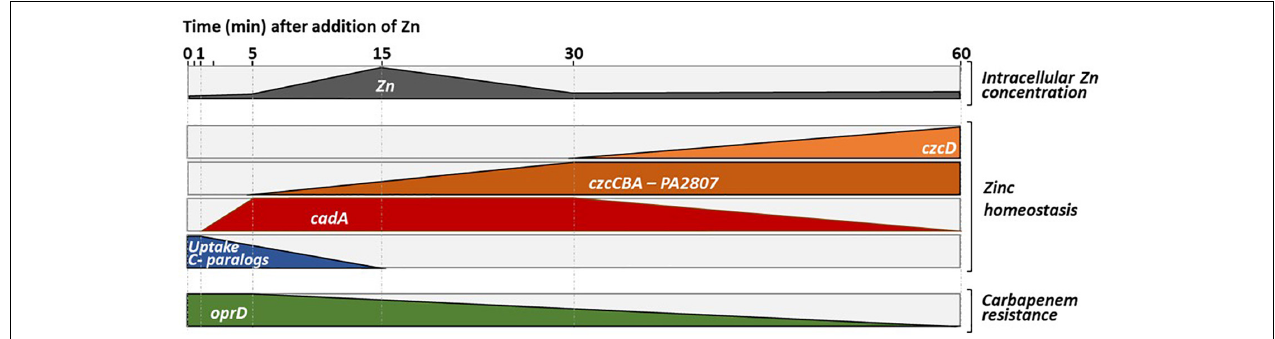
FIGURE 8 | Representation of the dynamics of Zn homeostasis in Pseudomonas aeruginosa. The first block represents the intracellular Zn concentration, which increases when the cells move from a Zn-poor to a Zn-rich environment. An increase in intracellular Zn concentration is observed for up to 15 min, the time it takes for the import systems to be repressed and for the export system to start to eliminate the excess Zn (see second block and discussion). Later it appears that the ATP-consuming CadA system, is replaced by a less energy-demanding CzcD system that takes over to pump cytoplasmic Zn into the periplasm. This representation, highlights the repression of the expression of the OprD porin whose abundance is inversely proportional to resistance to the family of carbapenem antibiotics (last